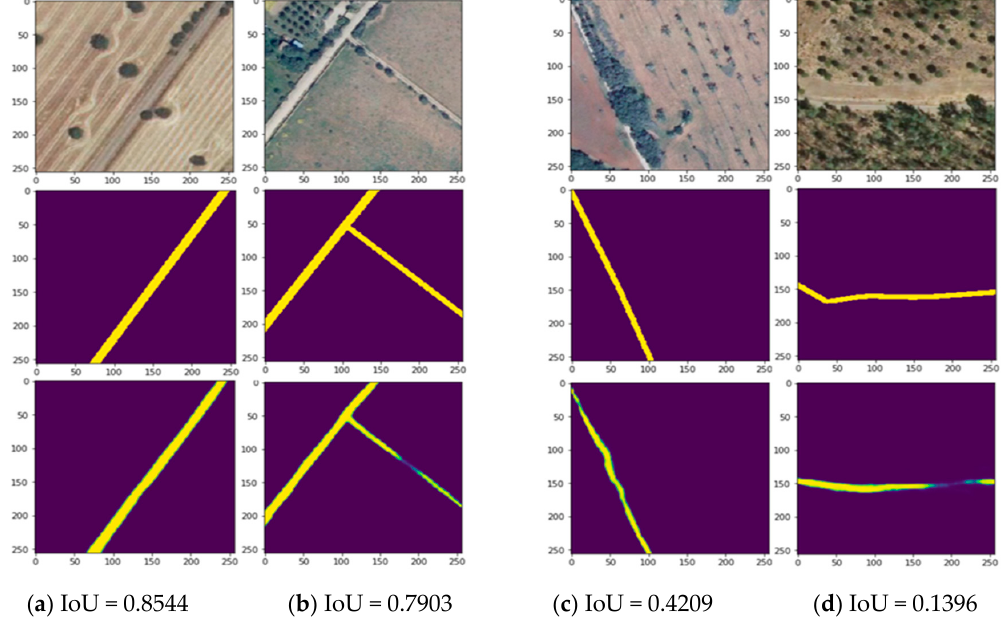
Figure 7. Predictions (third row) and IoU scores obtained by configuration 5 trained on 7750 tiles together with their correspondent ground-truth masks (second row). Note: The probability scores are plotted using a colormap that allows a better identification of ambiguous areas (where probability scores are close to 0.5). This way, purple is used to represent pixels labelled with “No road”, yellow is used to represent pixels belonging to the class “Road Exists”, and scales of blue were chosen to represent pixels with probability scores in proximity to